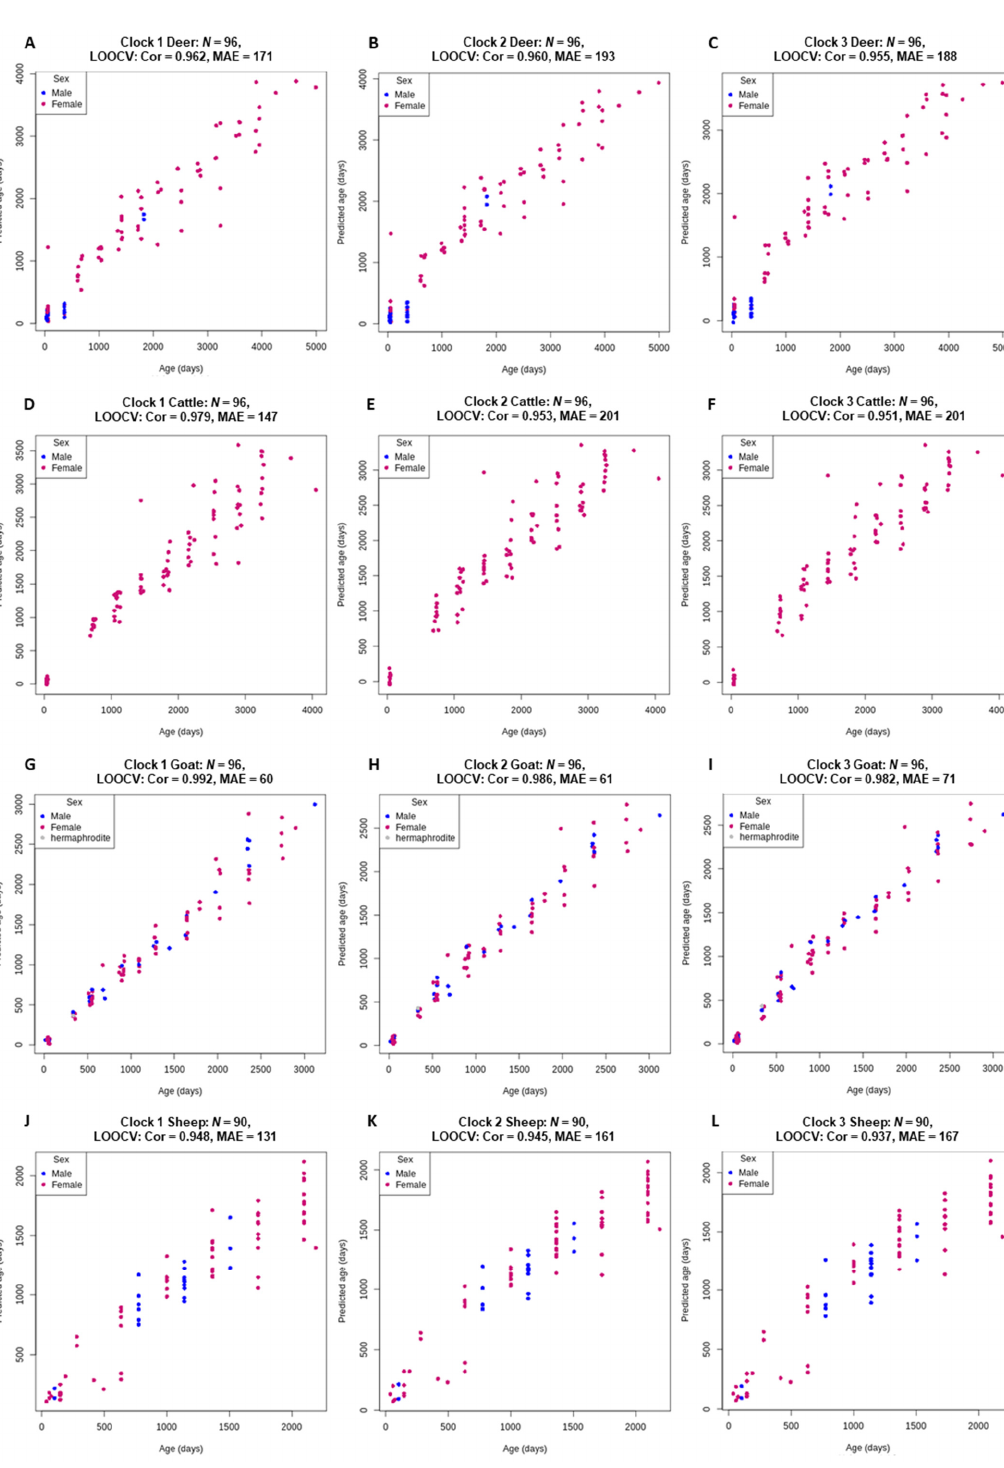
Figure 2. Chronological age (x-axis) versus back transformed epigenetic age estimated using clock 1 (log transformed chronological age; ( A , D , G , J )), clock 2 (loglogRelativeAge; ( B , E , H , K )) and clock 3 (log-linear transformed age; ( C , F , I , L )). For all four species, deer ( A – C ), cattle, ( D – F ), goat ( G – I ) and sheep ( J – L ). Pearson’s correlation coefficient estimates (Cor) and median absolute error (MAE) are reported for the age estimates via